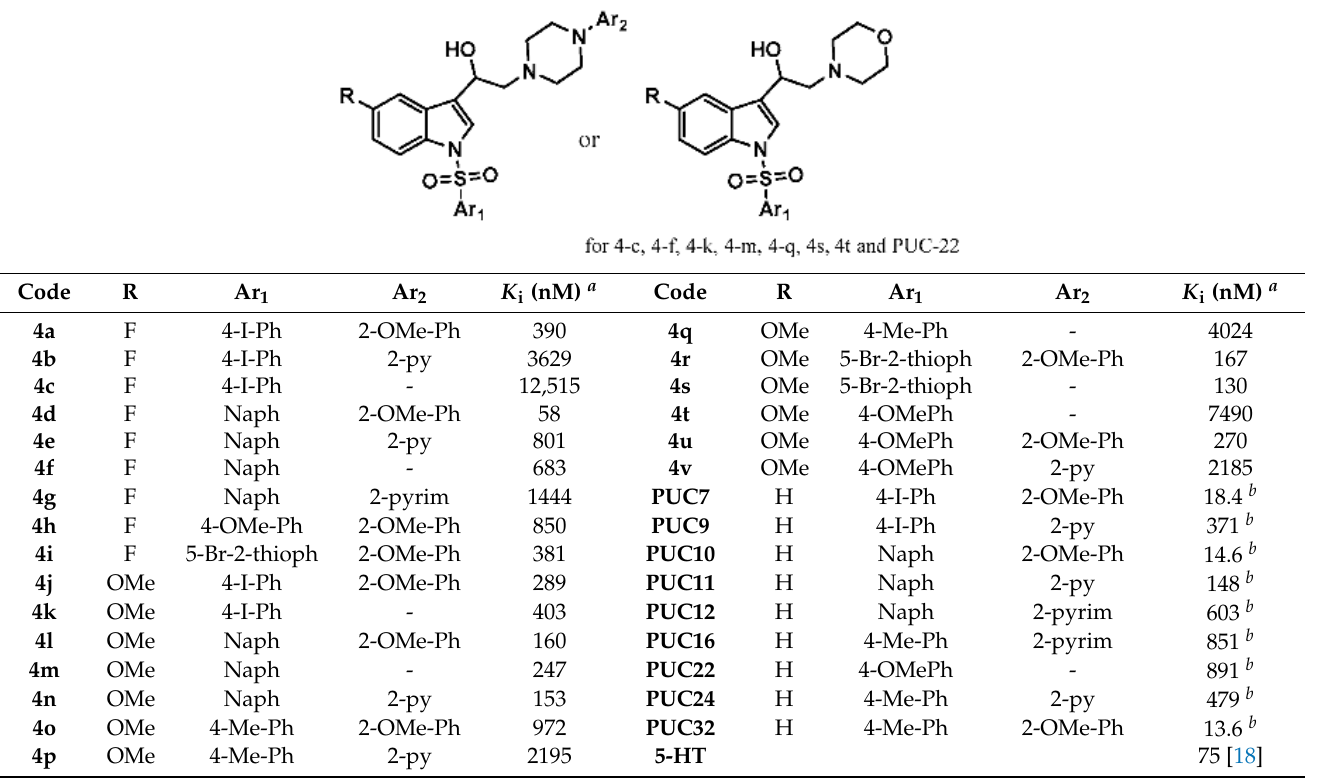
a Displacement of [ 125 I]-SB-258585 bound to cloned 5-HT 6 human receptors stably expressed in HEK-293 cells. IC 50 values (not shown) were determined in triplicate and K i were calculated using Cheng–Prusoff equation [25]. In this assay, the IC 50 value of Clozapine (Clz) was 12.4 nM; K i = 11.9 nM. b K i values for unsubstituted derivatives previously reported